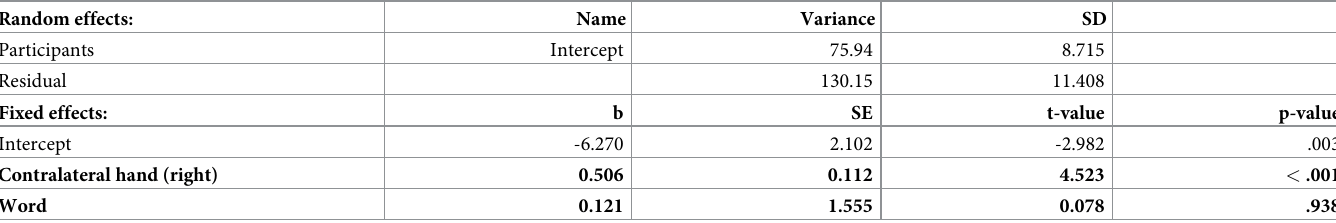
Table 14. Model 3.4. Effect of Direction on the left grip force (after controlling for the contralateral force) in the time window 810–890 ms (Experiment 3).